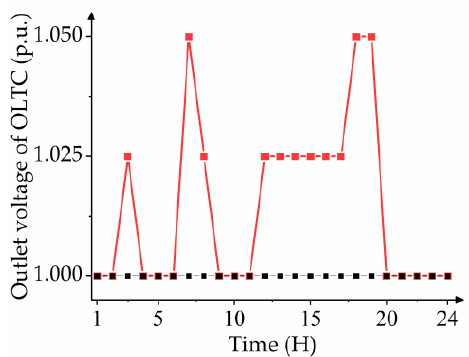
Figure 3. The outlet voltage of an on-load tap changer (OLTC).